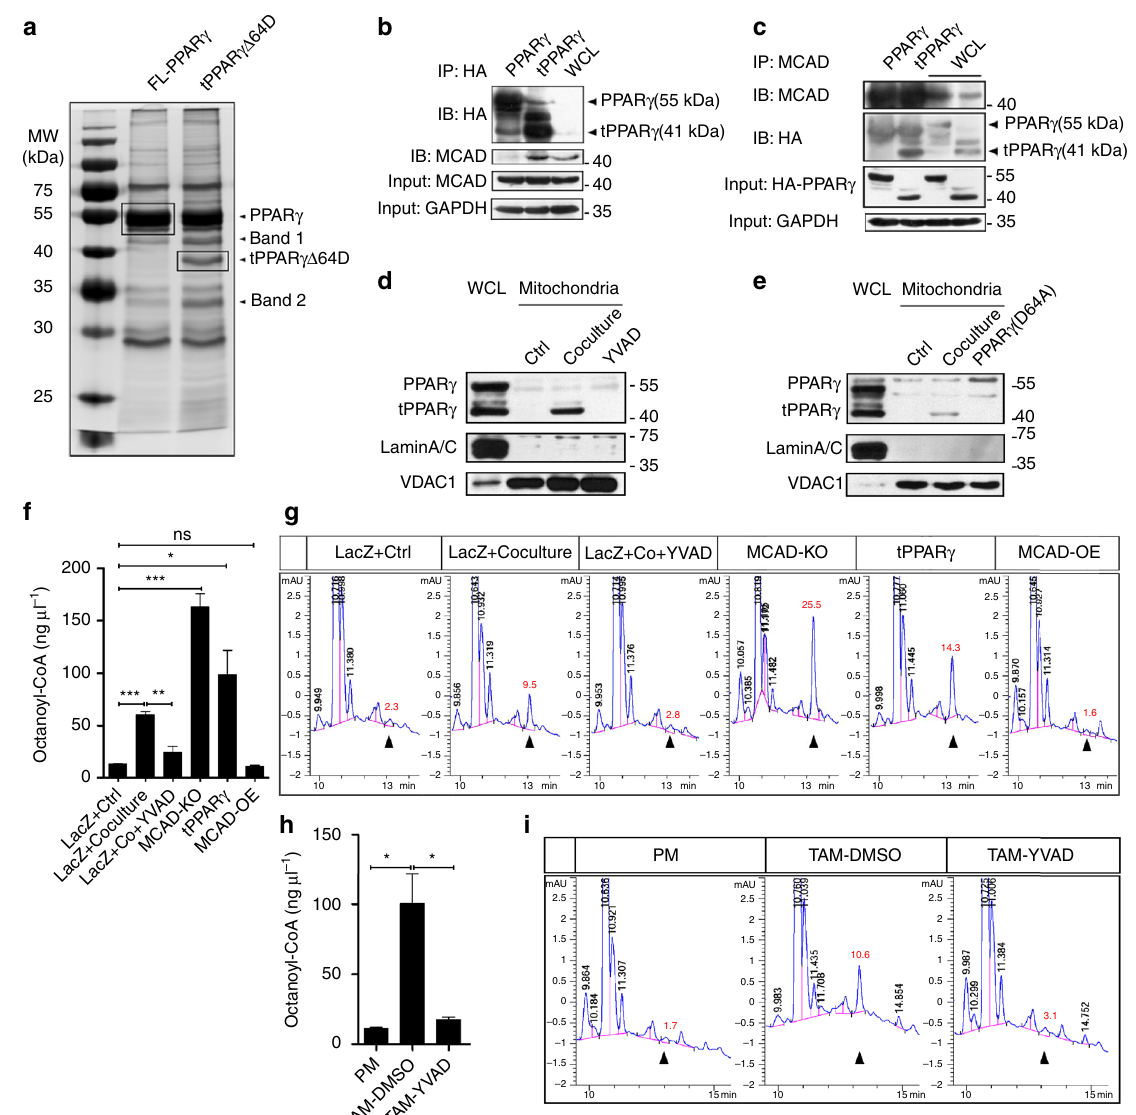
Fig. 6 tPPAR γ enriches in mitochondria and binds to MCAD and then impairs its activity. a A representative silver stained gel showing examples of the cellular proteins that speci fi cally interact with tPPAR γΔ 64D (band 1 and 2). The corresponding Coomassie staining gel was shown in Supplementary Figure 28. b , c THP-1 cells were transfected with HA-PPAR γ or HA-tPPAR γΔ 64D plasmids. Cell extracts were immunoprecipitated with anti-HA antibodies, then, analyzed with anti-HA antibodies or anti-MCAD antibodies ( b ), or the same cell extracts were immunoprecipitated with anti-MCAD antibodies, then, analyzed with anti-MCAD antibodies or anti-HA antibodies ( c ). MCAD expression or PPAR γ expression in two transfected THP-1 cells or nontransfected cells was determined by immunoblot. d , e Extracts of the mitochondrial protein of THP-1 cells that cocultured with MCF-7 for 48 h in the absence or presence of YVAD ( d ), or transfected with mutant PPAR γ (D64A) ( e ) were analyzed by immunoblot, laminA/C and VDAC1 as the loading control. PPAR γ and tPPAR γ in whole-cell lysates (WCL) in cocultured THP-1 macrophages was also shown. f LacZ overexpressing THP-1 cells were cultured alone or cocultured with MCF-7 in the absence or presence of YVAD for 24 h, MCAD knockout THP-1 macrophages, tPPAR γ overexpression THP-1 macrophages (wild type PPAR γ was deleted) and MCAD overexpression THP-1 macrophages were cultured alone for 24 h, then MCAD activity was analyzed by HPLC. Remaining octanoyl coenzyme A was negatively correlated with MCAD activity. Statistical results of total three trials were shown ( n = 3). g One representative HPLC result was shown, the peak area of octanoyl coenzyme A was shown (mAU*s). h Peritoneal macrophages were isolated from tumor bearing MMTV-PyMT mice, and TAMs were isolated from tumor bearing MMTV-PyMT mice administration of vehicle or caspase-1 inhibitor YVAD, MCAD activity was analyzed by HPLC. TAMs in each sample were pooled from three mice ( n = 3). i One representative HPLC result was shown. All the histograms in this fi gure show means ± s.e.m., ( n = 3, * P < 0.05, ** P < 0.01, *** P < 0.001, ns, not signi fi cant, one way ANOVA for multiple